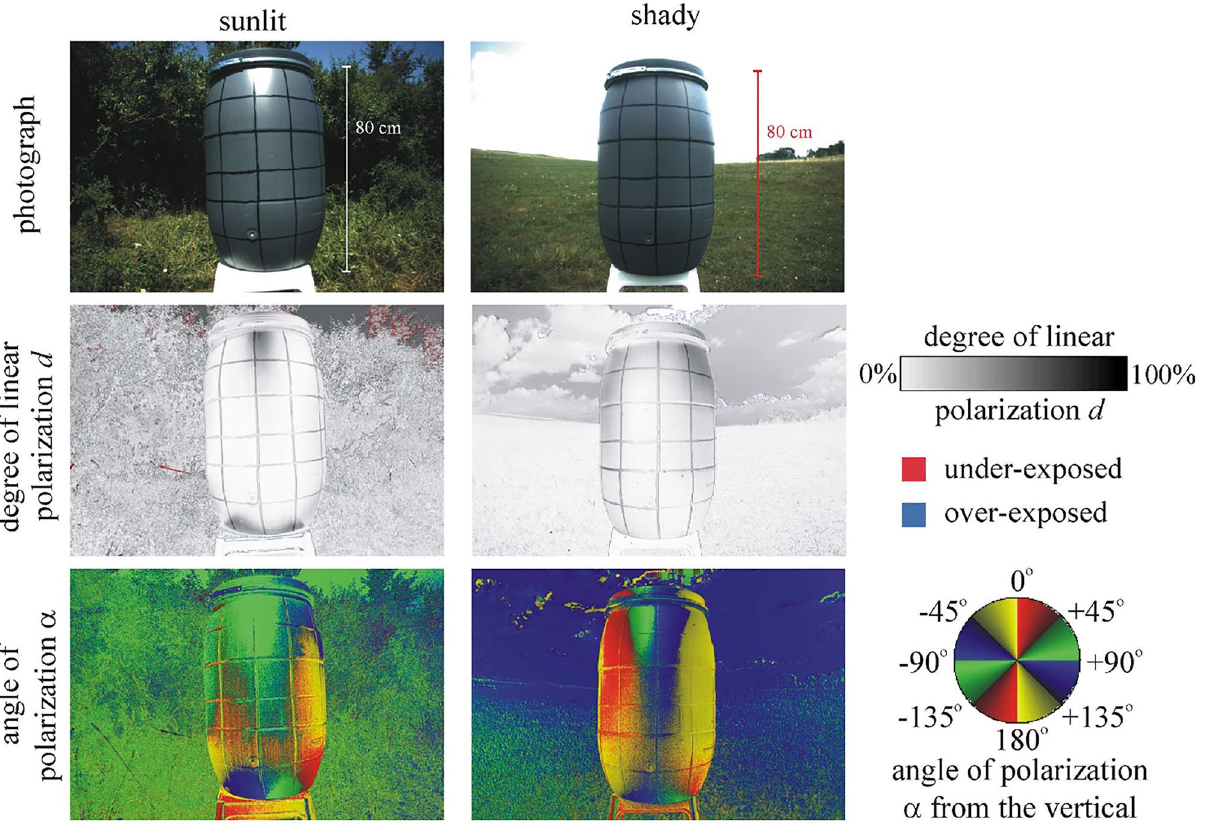
Figure 1. Reflection-polarization patterns of the sunlit (left column) and shady (right column) black-striped grey barrel used in the field experiment measured with imaging polarimetry in the green (550 ± 40 nm) spectral range when the optical axis of the polarimeter was horizontal. More details of the reflection-polarization characteristics of this target can be seen in Supplementary Figs. S2 and this undangerous thermal recording was equivalent with a common photography, for which no approval from an ethical committee is necessary. We confirm the followings: (i) For both studies no institutional permission, licence or approval were necessary. (ii) No animals (neither horseflies, nor horses) were killed specifically for the purpose of these studies. Field experiment with a black‑striped grey barrel. Our experiment was performed from 7 July to 9 August 2021 on a horse farm in Szokolya (47° 52’ North, 19° 00’ East, Hungary) with an abundant horsefly population, where several other experiments with tabanids have been conducted in the last decade 32,42,54,60–62 . On the experimental days (Supplementary Table S1) the weather was sunny and warm (25–38 °C) with some cumulus clouds in the afternoon. The aim of this experiment was to imitate the slightly higher temperature of the skin over blood vessels of host animals (e.g. zebras and other ungulates) of tabanids. The dark host’s body was modelled by a medium grey (greyness g = 50%) cylindrical plastic (with low thermal conduction to keep the gradients of surface temperature) barrel (height h = 80 cm, radius r = 22 cm), and the vessels were imitated with 10 vertical and 5 horizontal black, thin (width w = 0.5 cm) stripes 13 cm apart (see the photograph of Figs. 1, 2, 3) composed of a common oil-based black paint. In sunshine these stripes were slightly warmer than their grey surroundings (which was shown by thermography), because the formers had greater light absorbance (smaller albedo) than the latters. Note that tabanids can sense the temperature of the grey or black regions of the barrel’s surface only when they contact them after landing. Although our test target (black-striped grey barrel) is very artificial relative to the real host animals of horse- flies, we did not measure the spectral reflectance of the black stripes of our grey barrel, and did not compare it with that of black stripes of zebras measured earlier in another field experiment (see Supplementary Fig. S10 of 44 ). Such a comparison was unnecessary, because in our present field experiment, the most important aspect was to imitate the fine temperature gradients of the host’s skin above blood vessels and at the borderlines of sunlit adjacent black and white zebra stripes, by adding sunlit thin black stripes to the grey barrel. According to the thermograms presented in this work (Figs. 2, 3, and 4, Supplementary Fig. S1) as well as in Figs. 3 and 5 of 44 , this imitation was appropriate. The surface area of the half barrel’s cylinder (which was monitored by a person, see later) is A m = r π h , and on it there were five vertical black stripes (Fig. 1) each with length h and width w . The surface area of the five